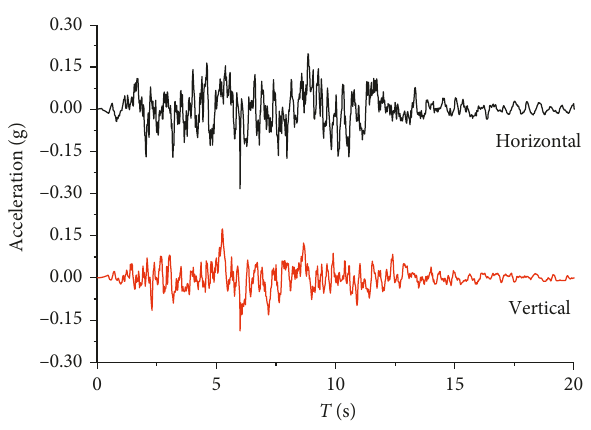
Figure 3: Accelerogram of input motion. Table 5: Parameters of static and cyclic shear strength.